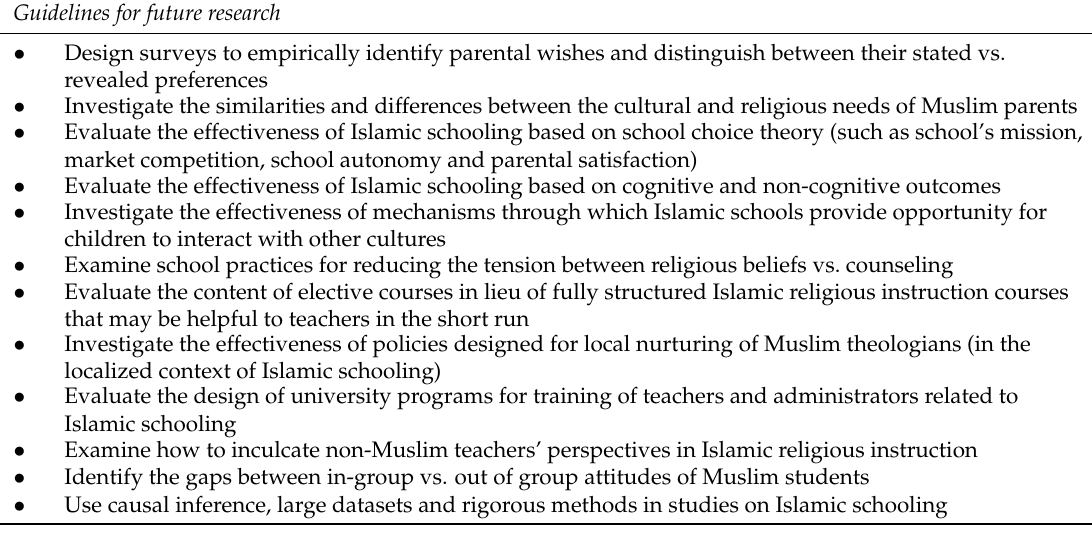
Table 6. Directions for future research concerning Islamic